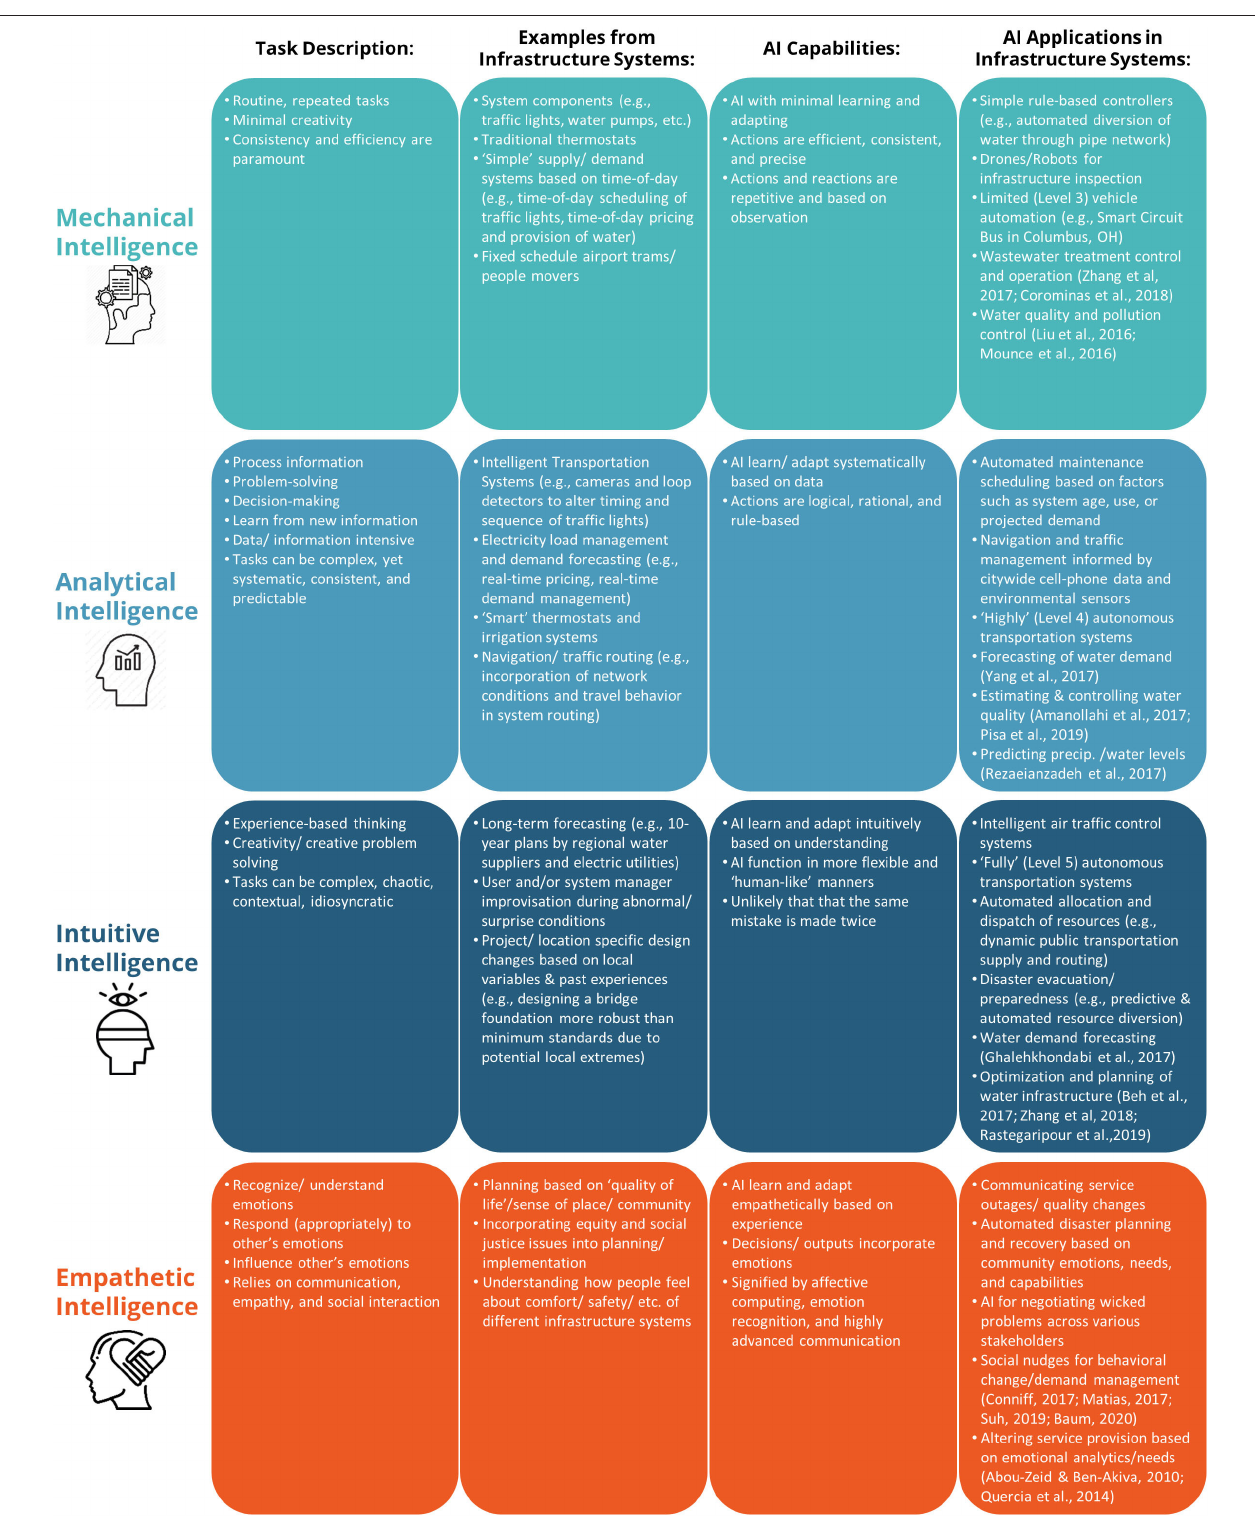
FIGURE 1 | Summary of the “Four Intelligences,” examples from infrastructure systems, and current/potential applications of AI to infrastructure systems across each level of intelligence.